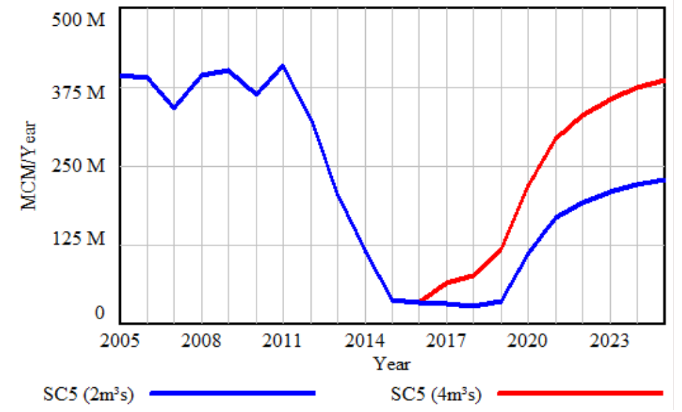
Figure 14. Impact of inter-basin water transfer on water